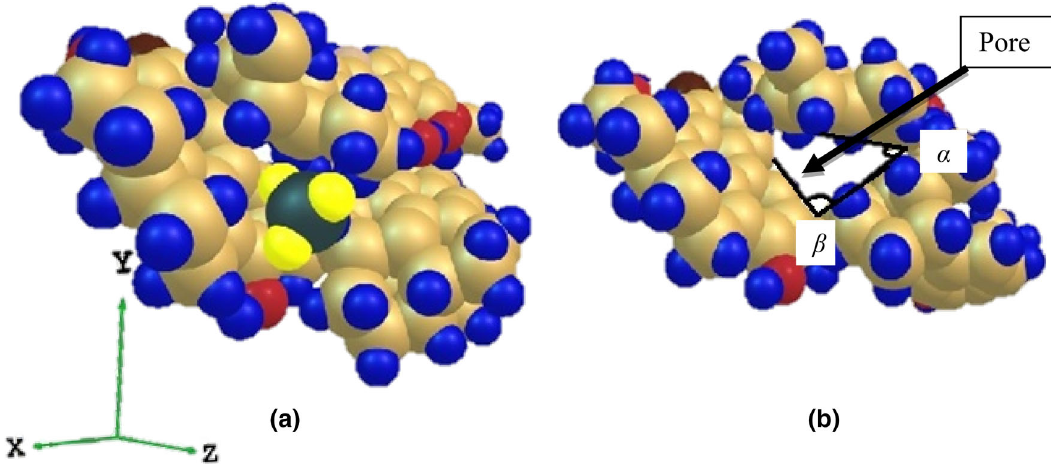
Fig. 2 Coal organic mass